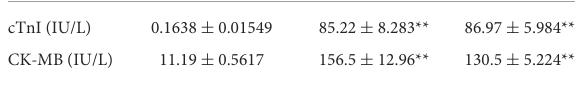
TABLE 3 The expression levels of cTnI and